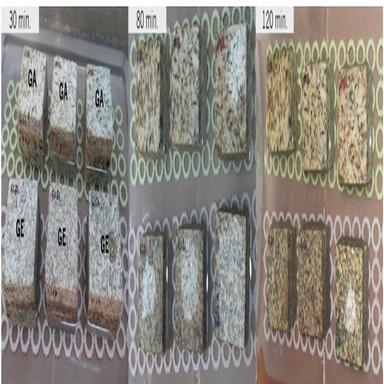
Water absorption at atmospheric pressure testing on granites.